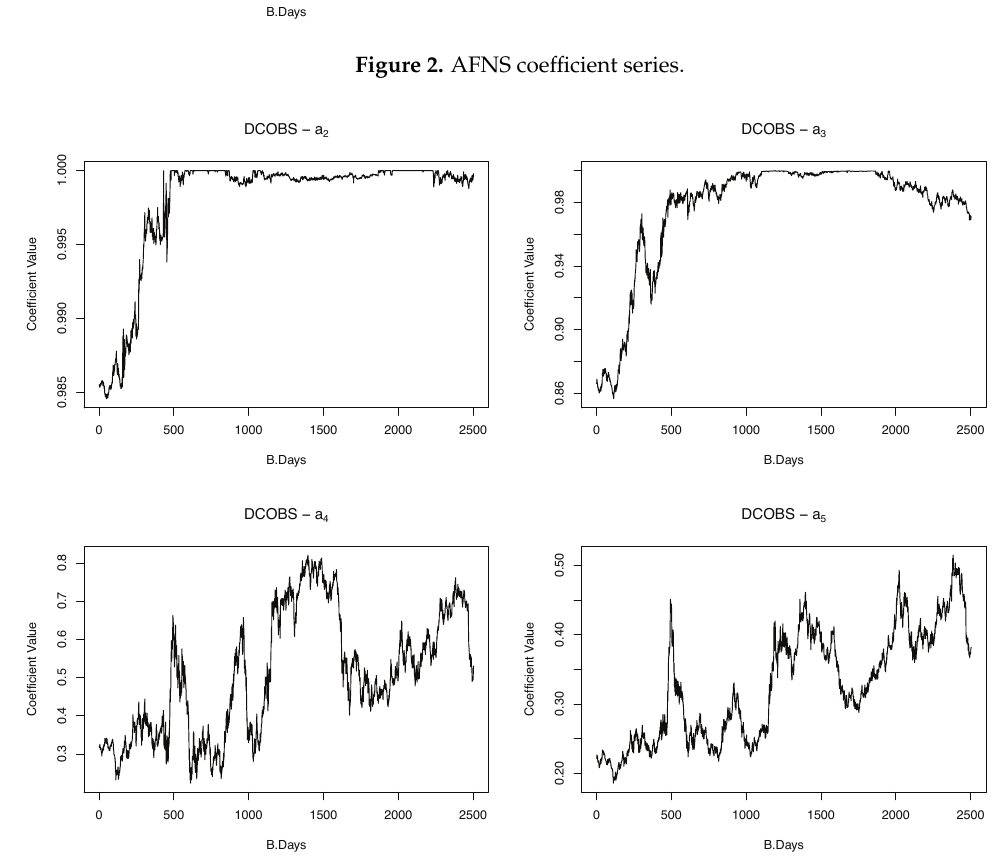
Figure 3. DCOBS estimated coefficient